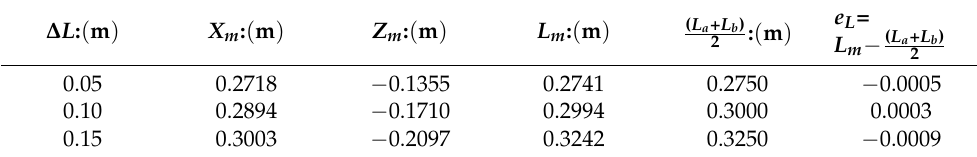
Table 4. The length of assumed backbone in difference ∆ L (data from experiment, L b =0.25 m).